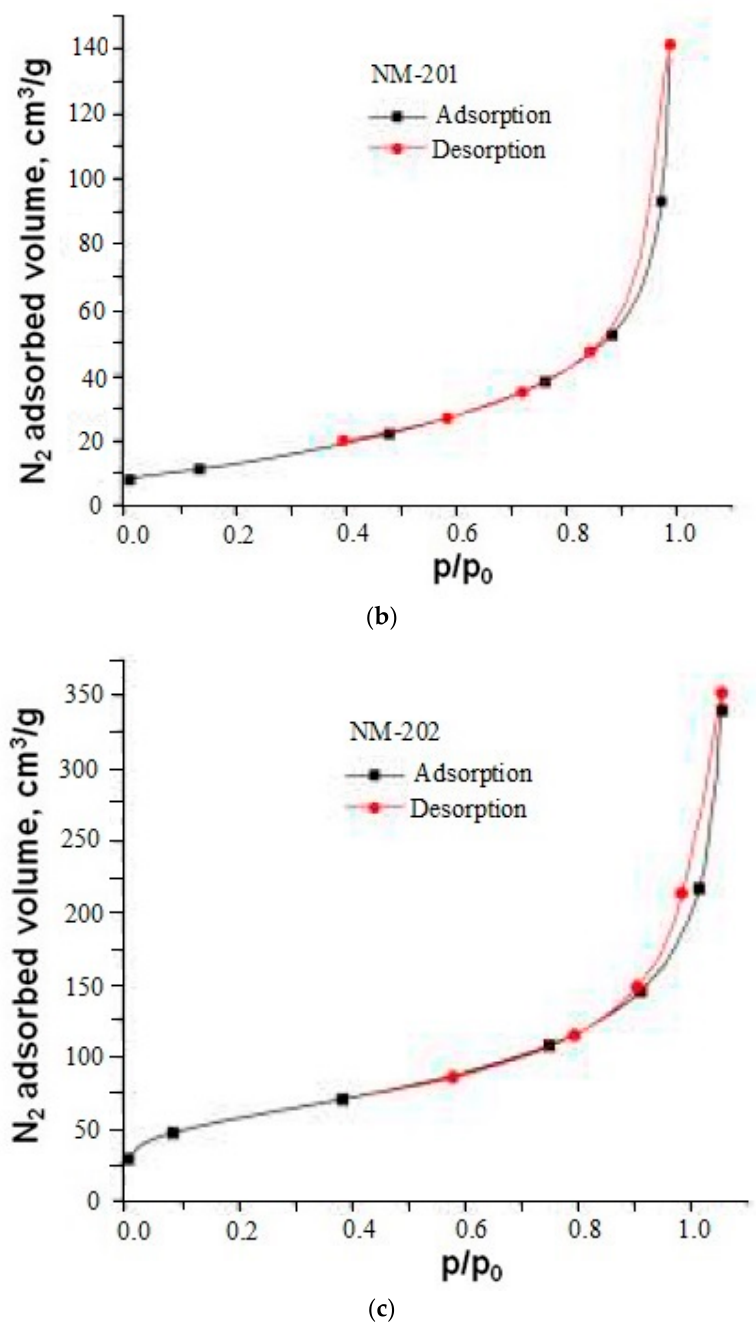
Figure 12. The curves of adsorption-desorption of precipitated NM-200, NM-201 and pyrogenic NM-202 samples of SiO 2 nanopowders: ( a ) sample NM-200, ( b ) sample NM-201, ( c ) sample NM-202 [1]. Table 4. Pore characteristics of pyrogenic and precipitated SiO 2 nanopowders [1] established by the BET(Brunauer–Emmett–Teller)-method.